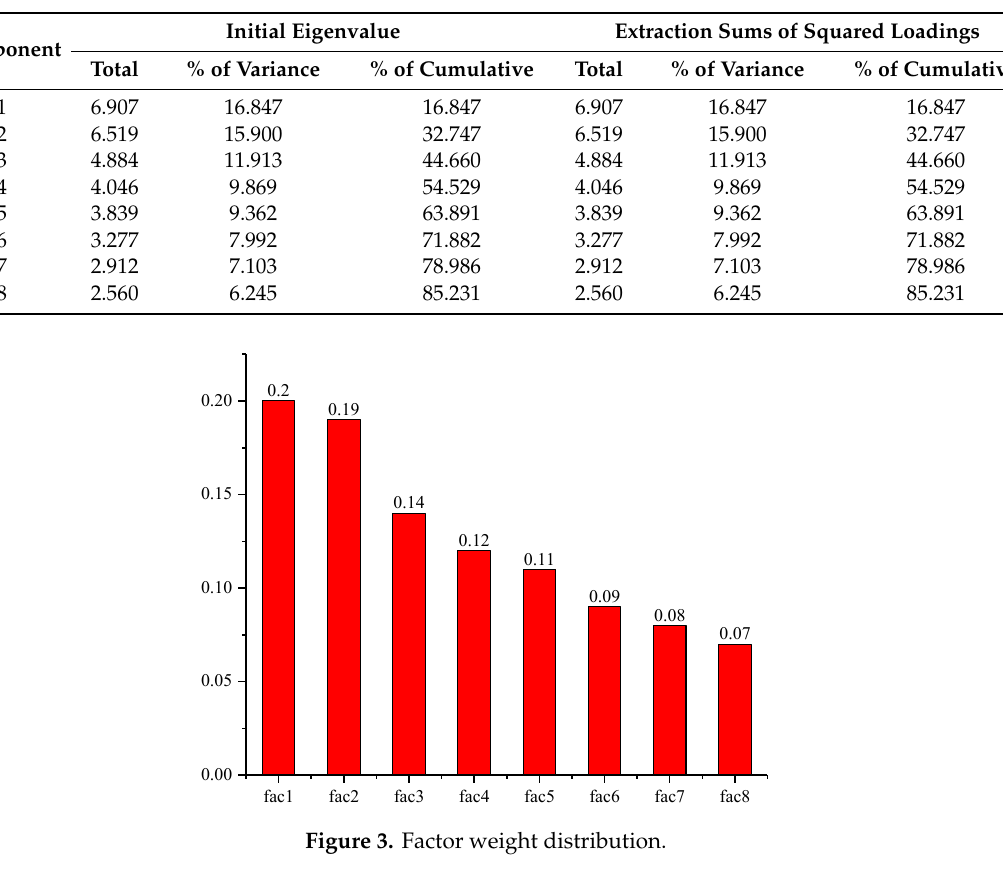
Table 2. Variance interpretation table.